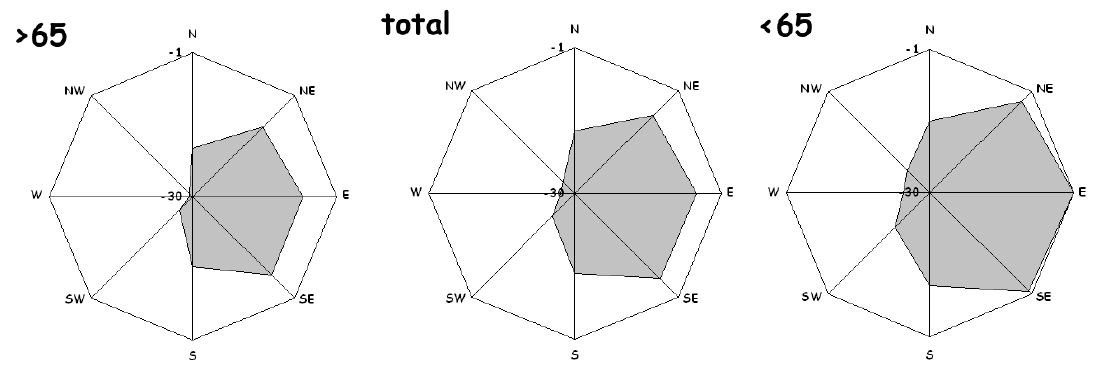
Figure 7. Rose diagrams for the mean elevation difference per geographic direction, for the study area (total area) as well as the 2 terrain subclasses formed by grid points with canopy density in the range [0,65] and [66,100]. The elevation difference assigned to the radius of each rose-diagram was within the range [-30, -1]